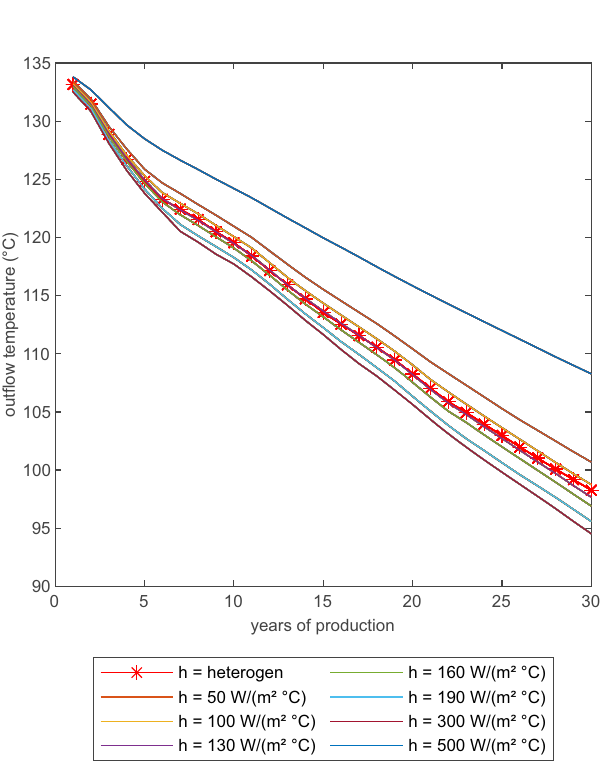
Fig. 5 | Numerical reservoir. Fracture network of the numerical geothermal reservoir with 116 fractures. The aperture ( a ) is calculated based on an assumed stress fi eldorientedroughlynorthtosouth.Linethicknessisenhancedforvisibility. Injection (red) and production borehole (blue) are marked for two well